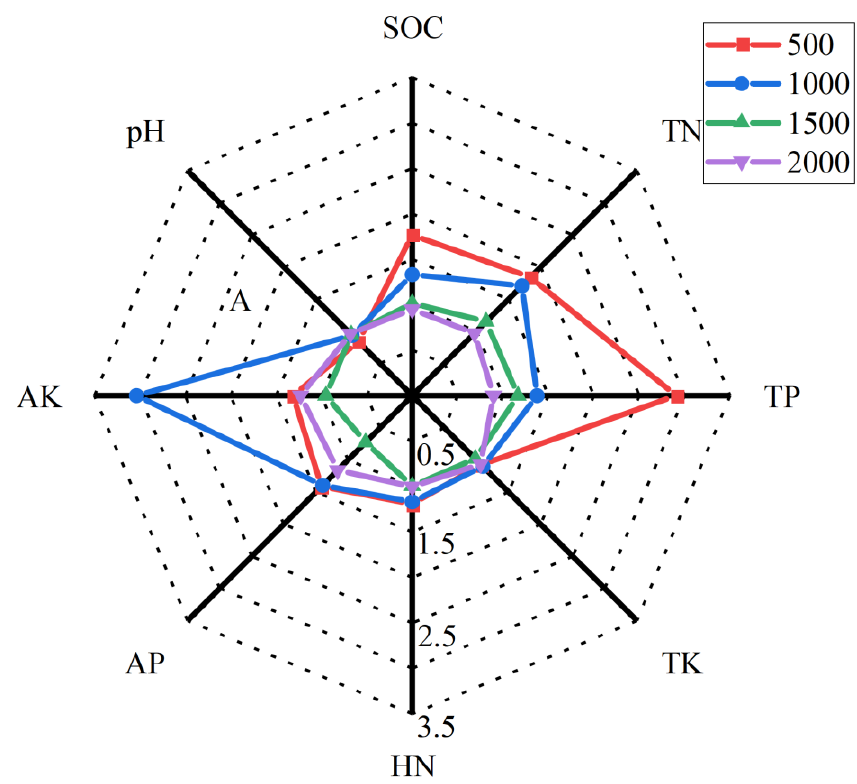
Figure 4. Radar map of rhizosphere effect (R/S = rhizosphere soil/bulk soil).